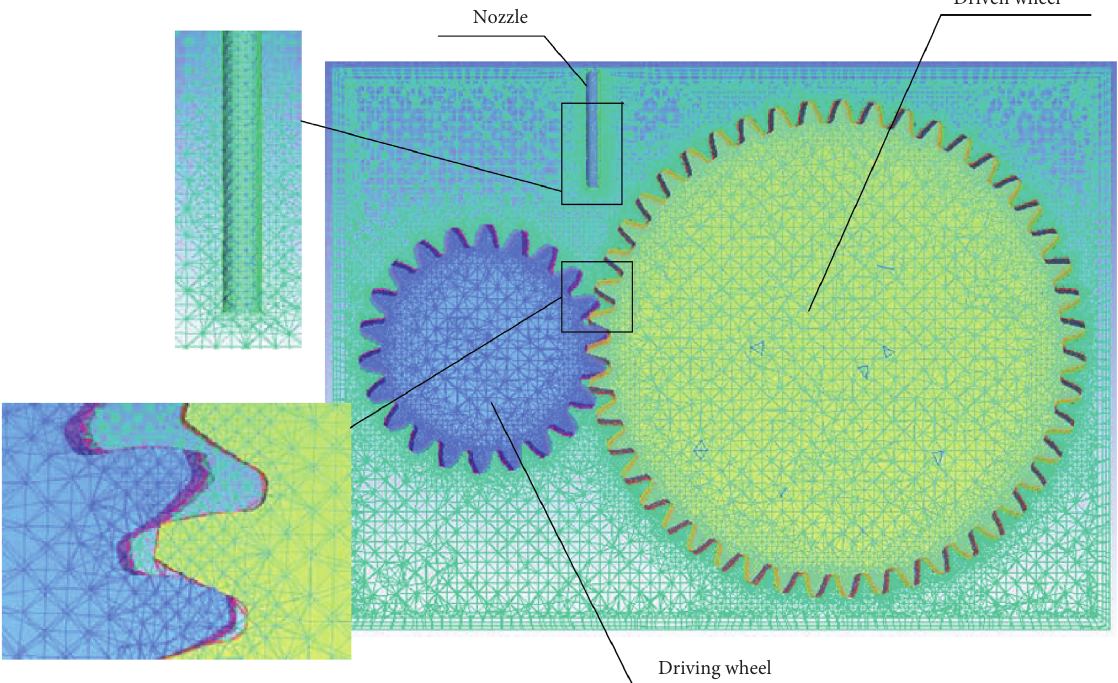
Figure 5: Mesh model of gear pair and box.